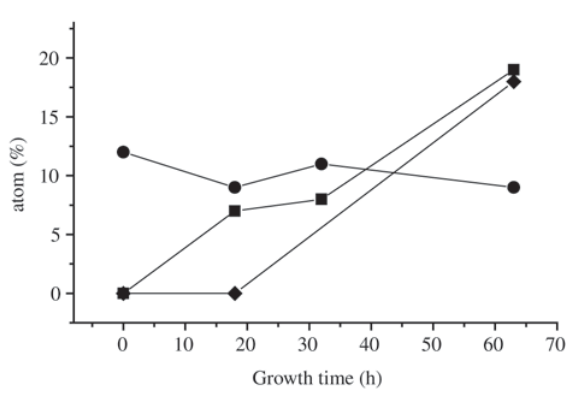
Figure 5. Change of C and N content on nitrated molybdenum surface and C content on nitrated molybdenum bulk as a function of the growth time. ( (cid:122) ) % atom on N on nitrated molybdenum surface; ( (cid:132) ) % atom C on nitrated molybdenum surface; ( (cid:139) ) % atom on C on nitrated molybdenum